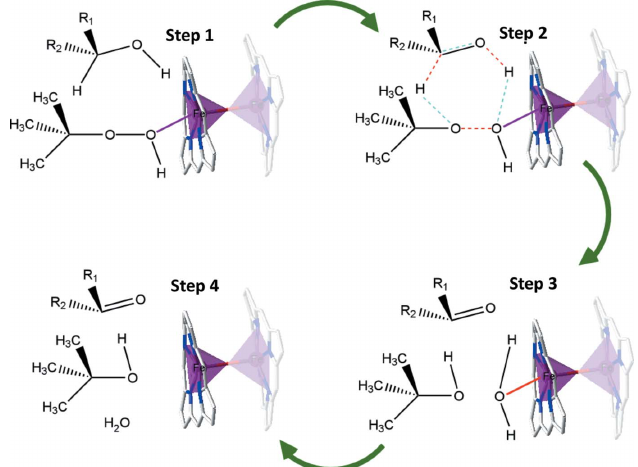
Figure 6 Proposed mechanism for the alcohol oxidations with TBHP over catalyst 2 . Colour code: Fe purple, C grey, N blue and O red. Bonds to be removed and created are marked in red and blue, respectively.